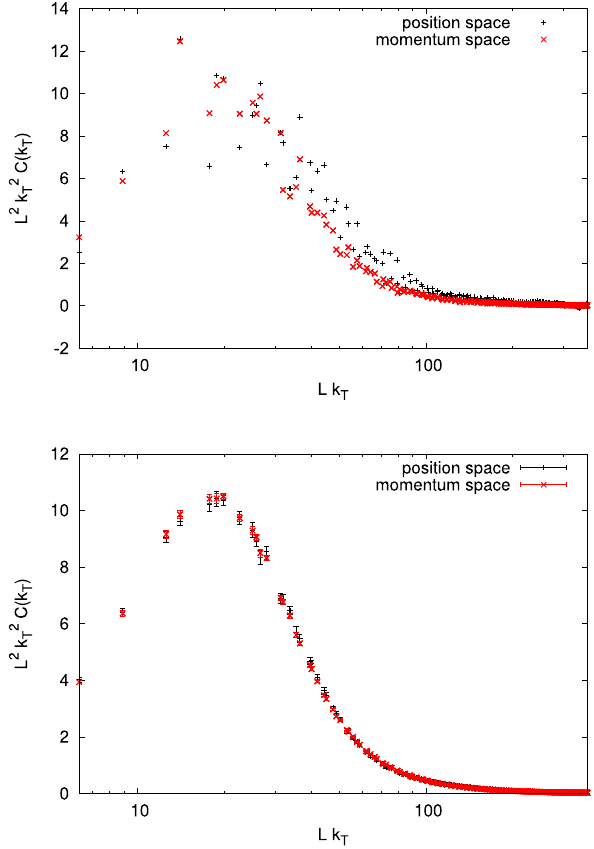
Fig. 1 Top: comparison of the correlation function estimated for a single realization of the initial condition. Bottom: comparison of the correlation functions estimated in momentum and position spaces for a statistics of 100 initial condition